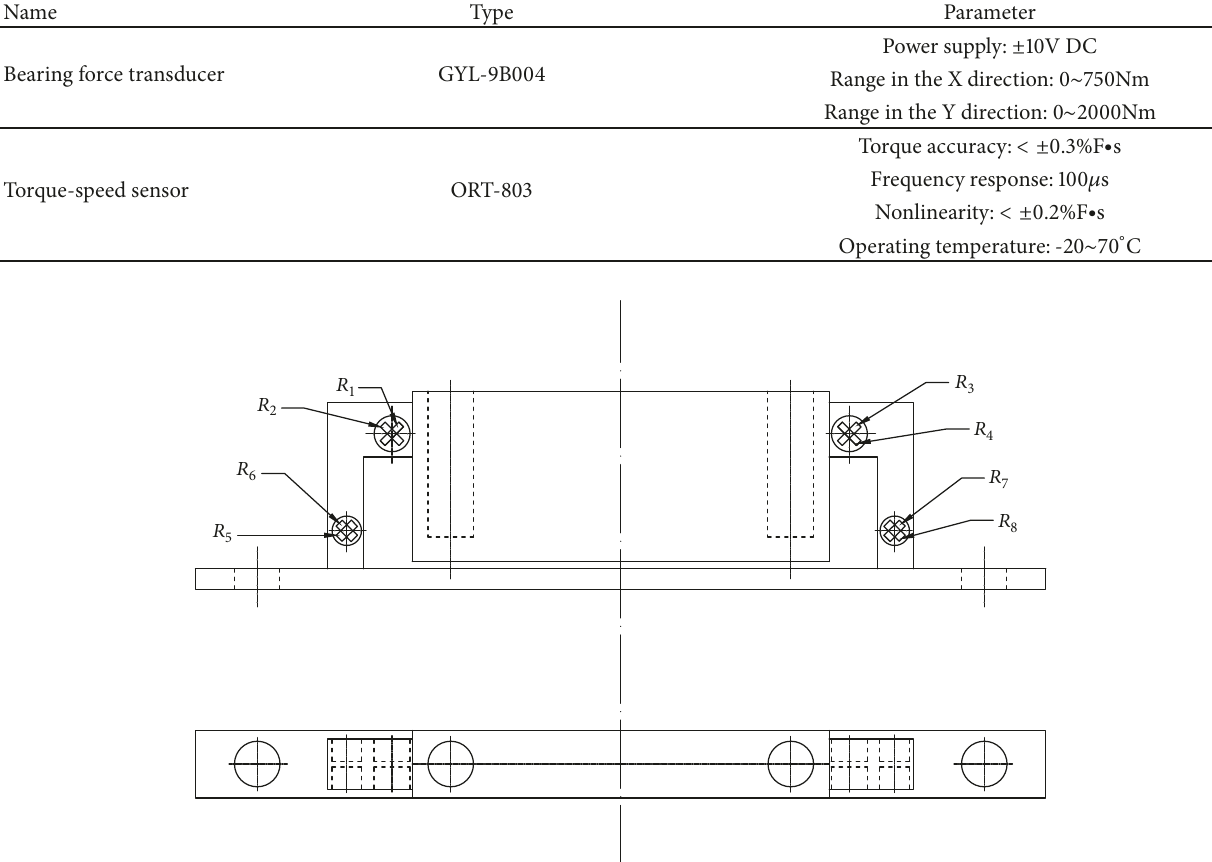
Figure 3: The bearing load sensor.